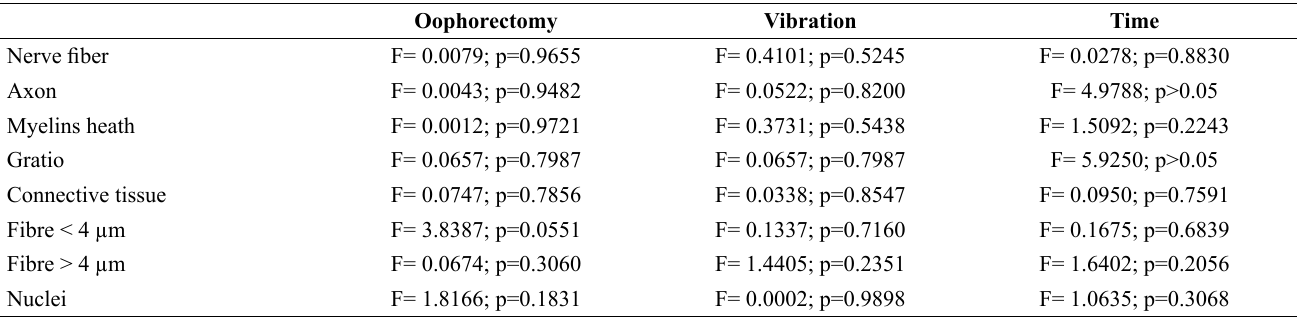
Table 4. Statistical values of nerve fiber diameter, axon and myelin sheath (μm), G ratio and percentage of connective tissue, considering oopho- rectomy, vibration and time